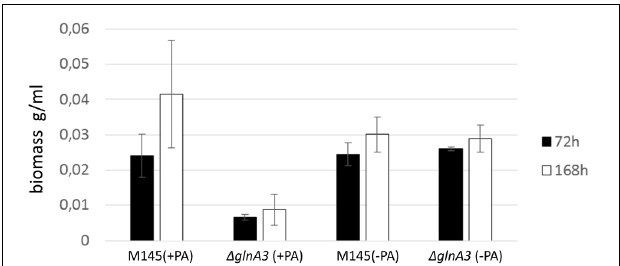
FIGURE 8 | Effect of the glnA3 deletion on a biomass accumulation in a rich complex medium supplemented with and without polyamines. Monitoring of changes in biomass accumulation of the parental strain S. coelicolor M145 and (cid:49) glnA3 mutant in the YEME:TSB (1:1) medium supplemented with polyamines total concentration 100 mM (putrescine, cadaverine, spermidine, and spermine, 25 mM of each) after 72 and 168 h of incubation. Error bars indicate standard error of three biological replicates.